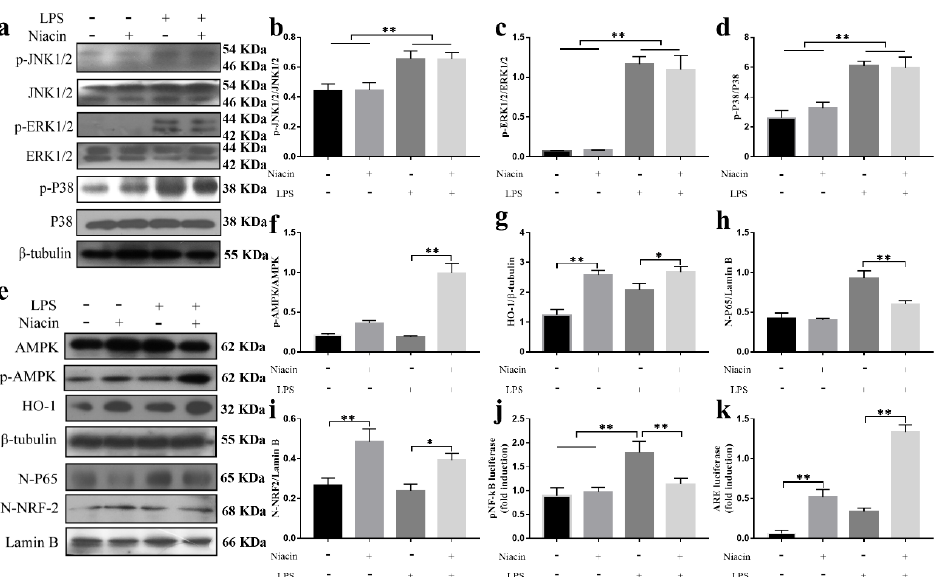
Figure 6. Effect of GPR109A on the AMPK/NRF-2/HO-1, P38, JNK1/2, and ERK1/2